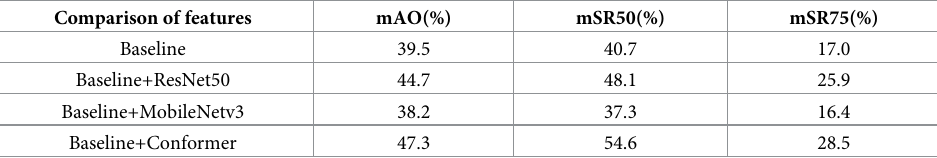
Table 5. Analysis of deep feature on